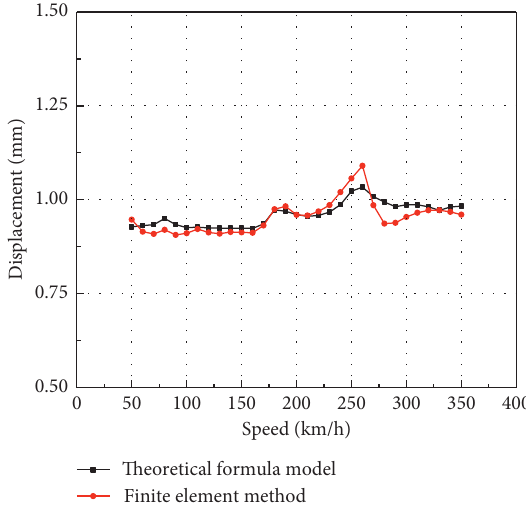
Figure 6: The maximum displacement of the bridge midspan under the two models at different speeds.